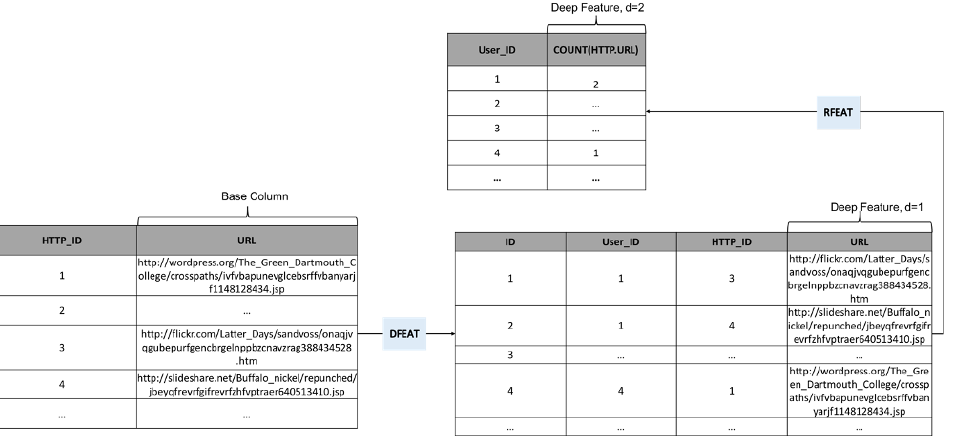
Figure 2. An illustration of a feature that DFS can produce.